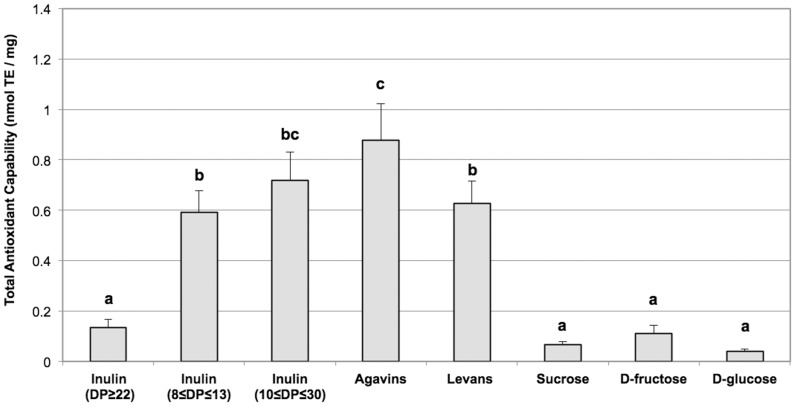
Total Antioxidant Capability of fructans.Fructans, with different molecular characteristics (DP and branching) and botanical origins, were tested for their antioxidant capability and compared to glucose, fructose and sucrose. Reported values are the means of six independent experiments ± SE. Values marked by the same letter are not statistically different (P>0.05; ANOVA test); values marked by different letters are statistically different (P<0.05; ANOVA test).